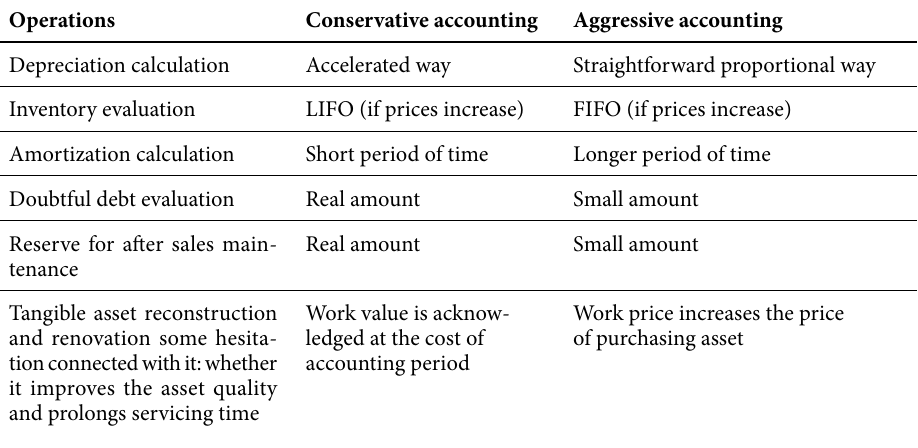
Fig. 3. The examples of aggressive and conservative accounting